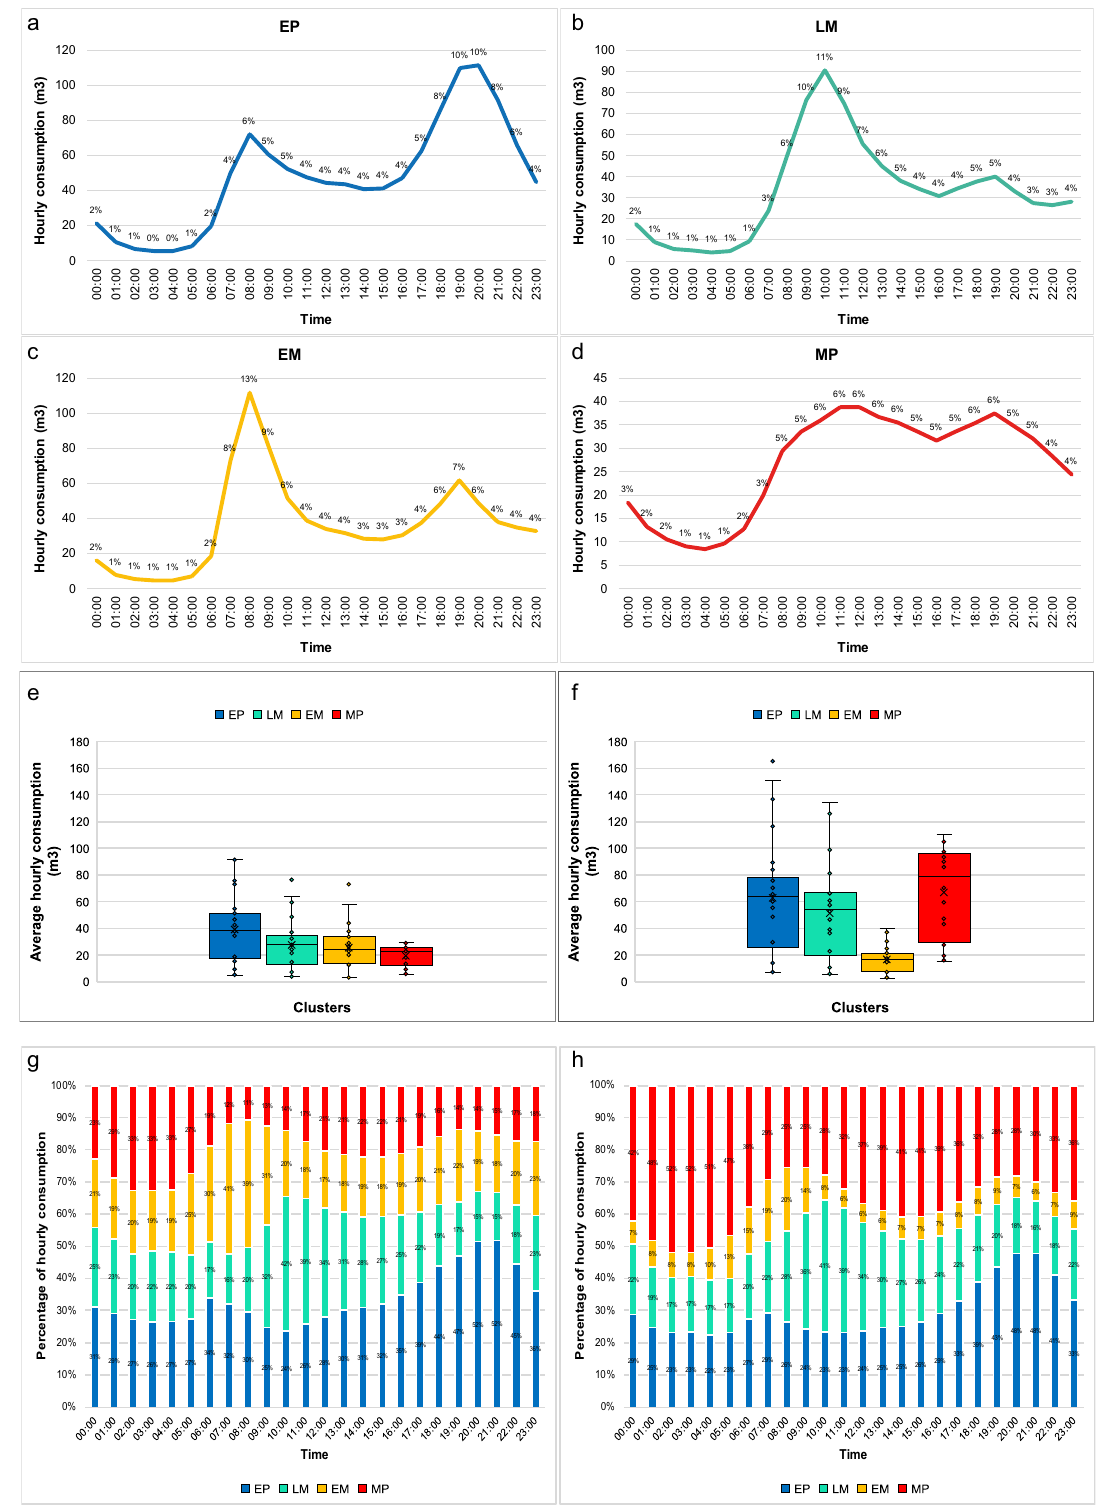
households during the lockdown period. This has resulted in an increase in their share of hourly consumption between 00:00 and 07:00 to an average of 45% – ~24 m 3 /hr; between 12:00 and 17:00 to an average of 39% – ~98 m 3 /hr and 23:00 to 36% – ~60 m 3 /hr (see Fig. 2h). Their share of the total daily consumption also rose